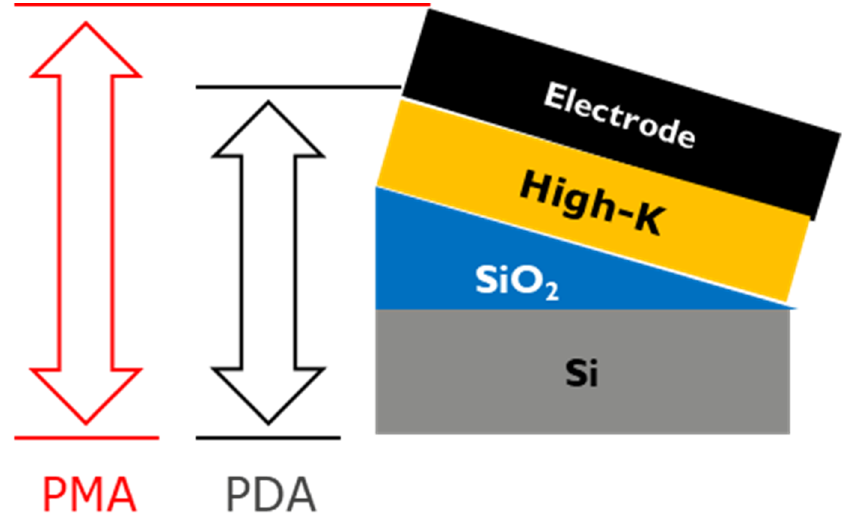
Figure 5. Schematic indicating different anneal types and the corresponding layers that received the process.